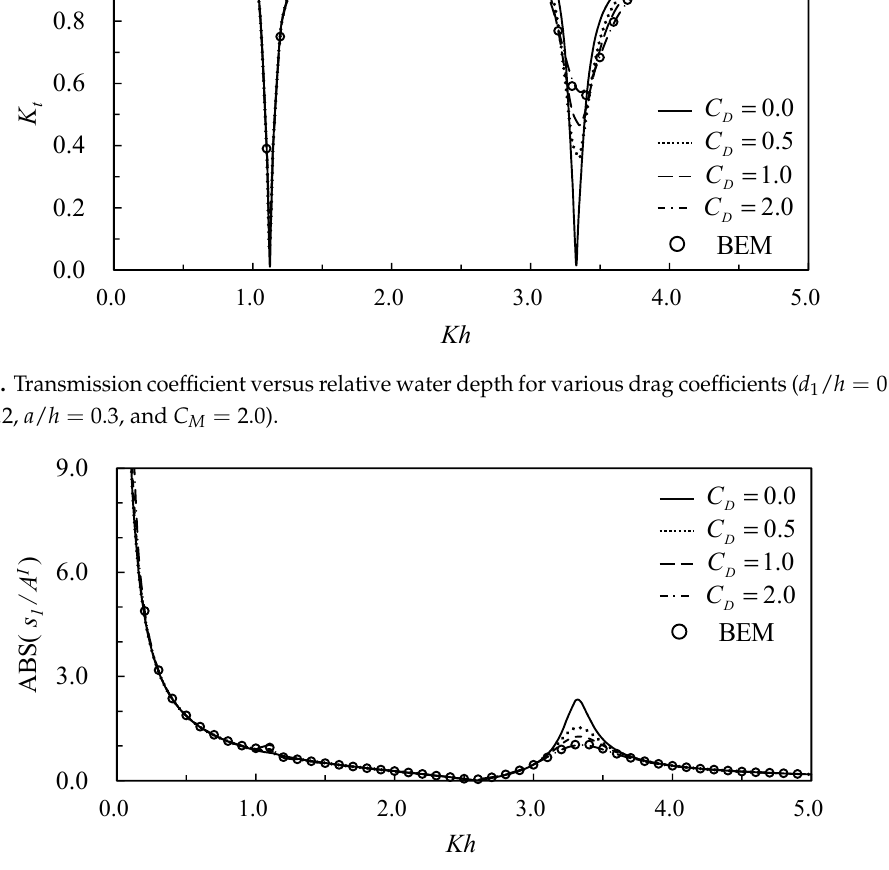
Figure 9. Surge motion amplitude versus relative water depth for various drag coe ffi cients ( d 1 / h = 0.25, (cid:96) / h = 0.2, a / h = 0.3, and C = 25.0 M